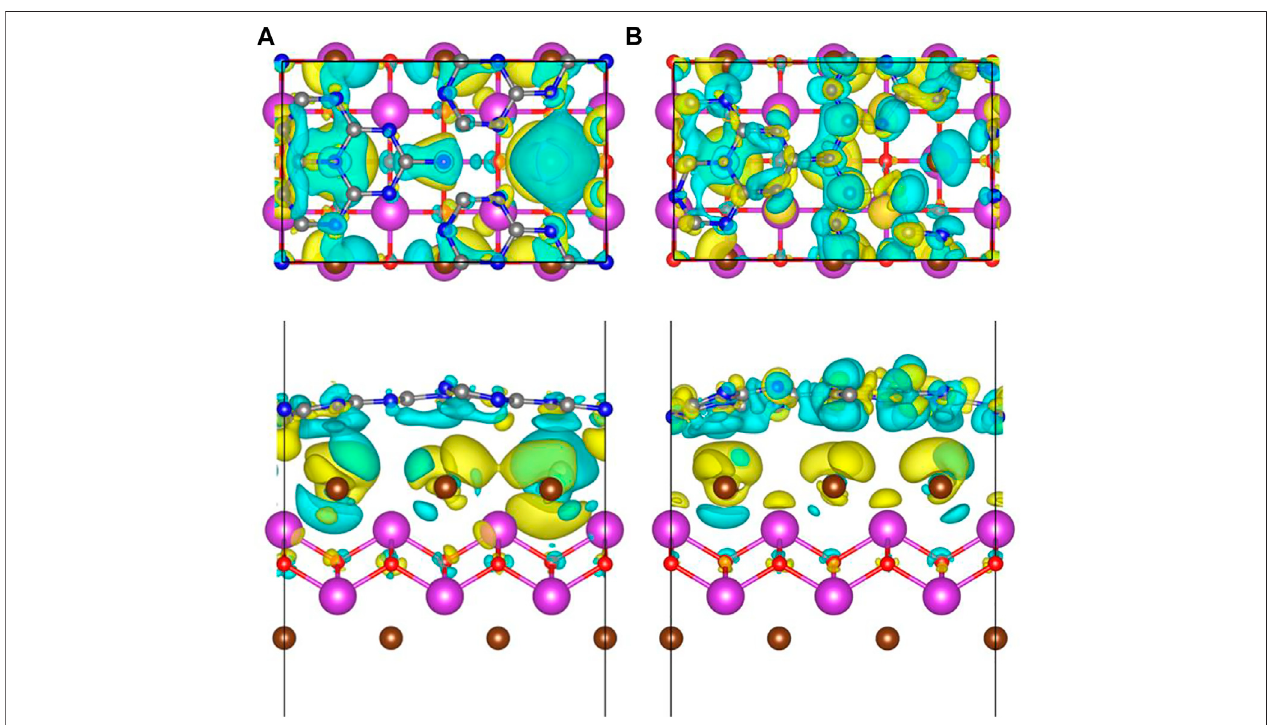
FIGURE 4 | The top and side view of charge density difference in (A) BiOBr/g-C 3 N 4 and (B) BiOBr/S-g-C 3 N 4 . The blue and yellow areas represent charge consumption and accumulation, respectively. The isosurface value was 0.3 e · nm − 3 .